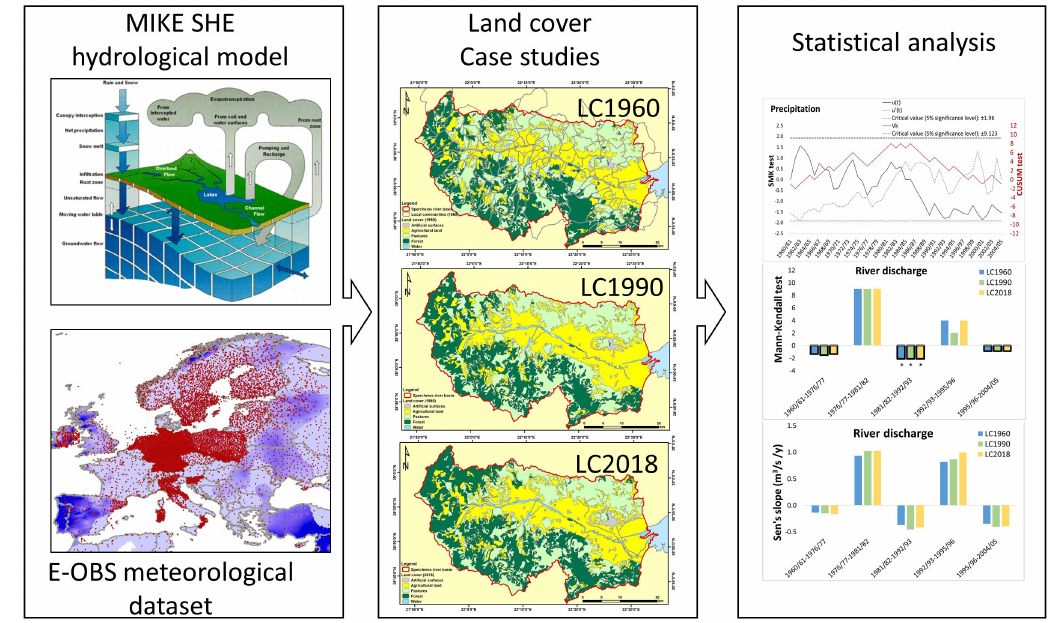
Figure 2. Flowchart of the current methodological